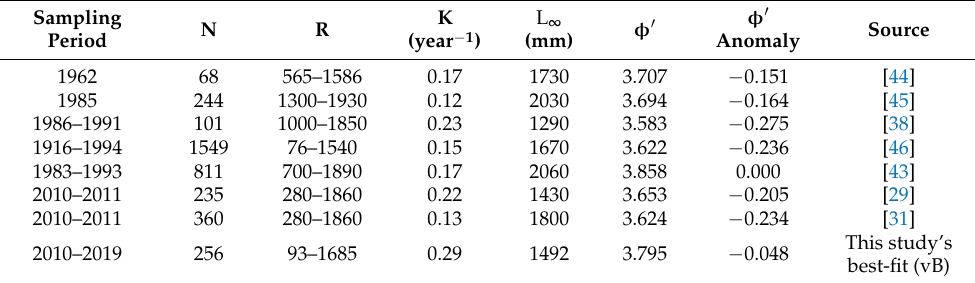
Table 3. The von Bertalanffy parameters k (y − 1 ), L ∞ (total length), growth performance φ (cid:48) values, and their anomalies, from previous investigations and the present study; N: Sample size; R: Size range. For ease of interpretation, the vB growth parameters are also